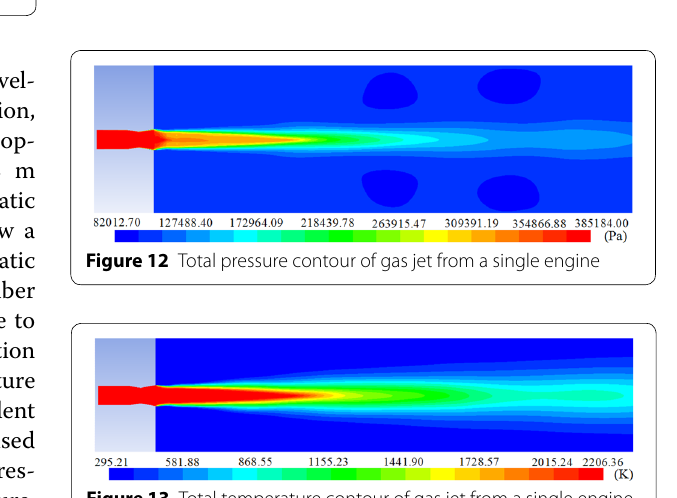
Figure 10 Axial static pressure, static temperature and Mach number curve of gas jet from the aircraft engine